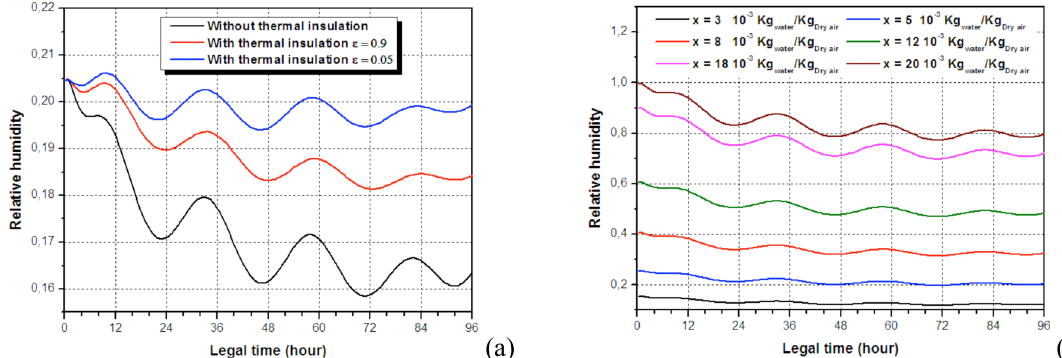
Fig. 5. Predicted relative humidity of the sitting room before the thermal storage as function as: (a) the thermal insulation level; (b) the water